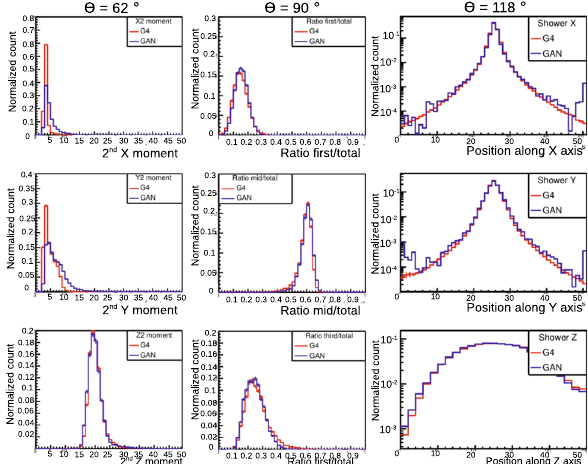
Fig. 10 GEANT4 vs. GAN comparison for shower width (second moment) in x, y, z, ratio of energy deposited in parts along direction of particle traversal to total energy and shower shapes along x, y, z axis in log scale for 100–200 GeV primary particle energies and 60 ◦ − 120 ◦